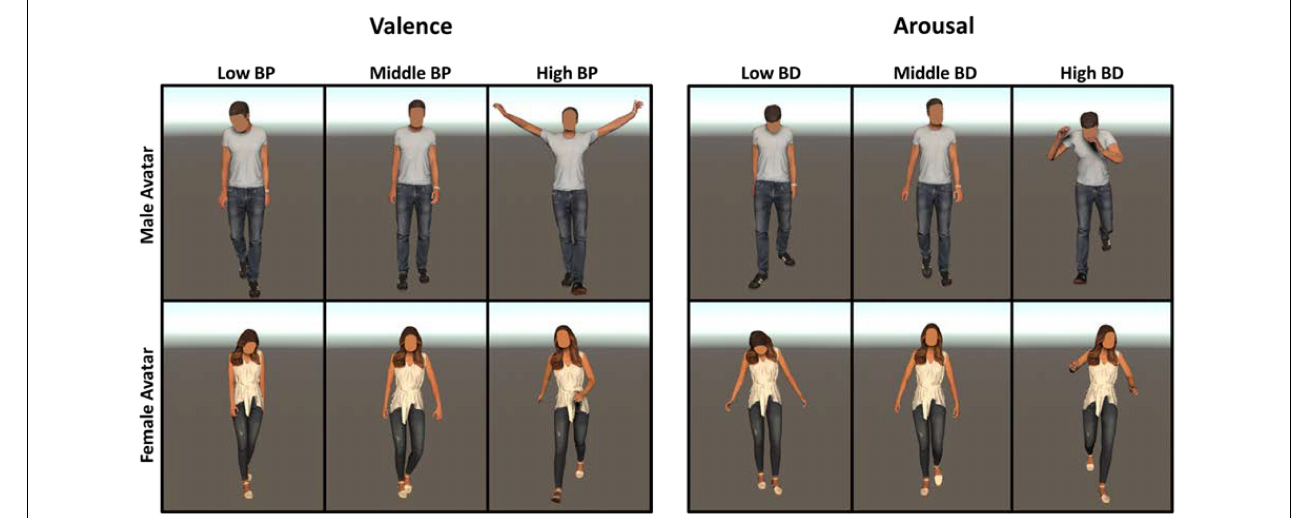
FIGURE 3 | Example of avatar’s body postures with different levels of BP (Left panels) and BD (Right panels) .